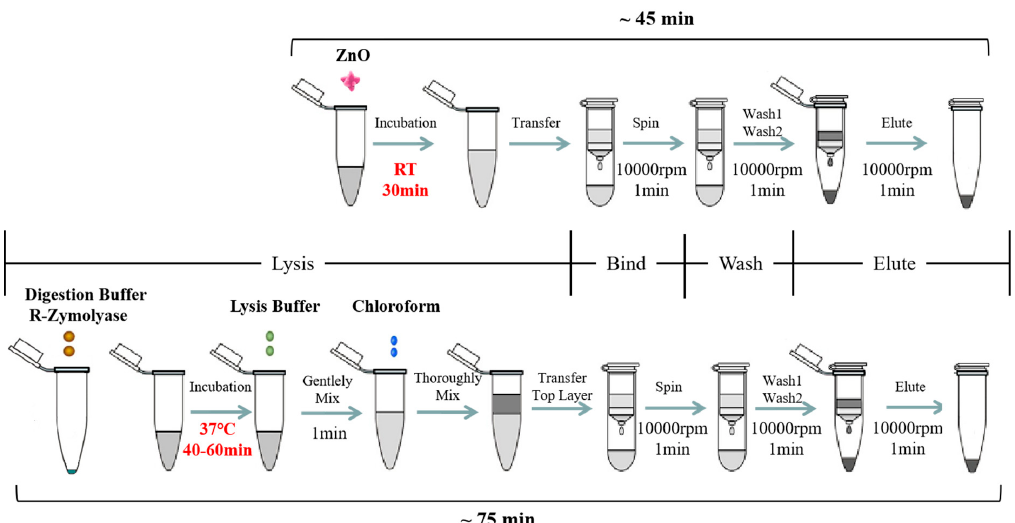
Figure 1. Diagram of the ZnO-based fungal DNA isolation assay. A schematic illustrating nucleic acid (NA) isolation using the lysis bu ff er replacement method based on ZnO (the ZnO-based fungal DNA isolation assay) instead of using the traditional lysis bu ff er in the commercial fungal DNA extraction kit. The ZnO-based fungal DNA isolation assay ( top ) and commercial kit assay ( bottom ) both have four steps involving di ff erent lysis bu ff ers but the same filter column, wash bu ff er, and elution bu ff er. For lysis process, in the optimized ZnO-based fungal DNA isolation assay, 100 µ L A. fumigatus spores was mixed with 100 µ g ZnO for 30 min at room temperature only without any further lysis step. In the commercial kit assay, 10 µ L A. fumigatus spores was mixed with 120 µ L of YD digestion bu ff er and 5 µ L of R-Zymolyase TM (RNase A + Zymolyase TM ) for 40–60 min at 37 ◦ C, then YD lysis bu ff er